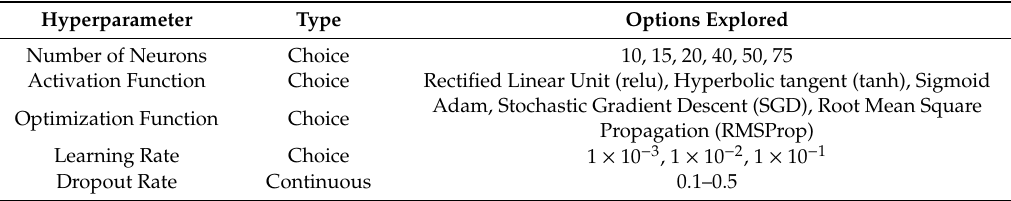
Table 4. Hyperparameter choices